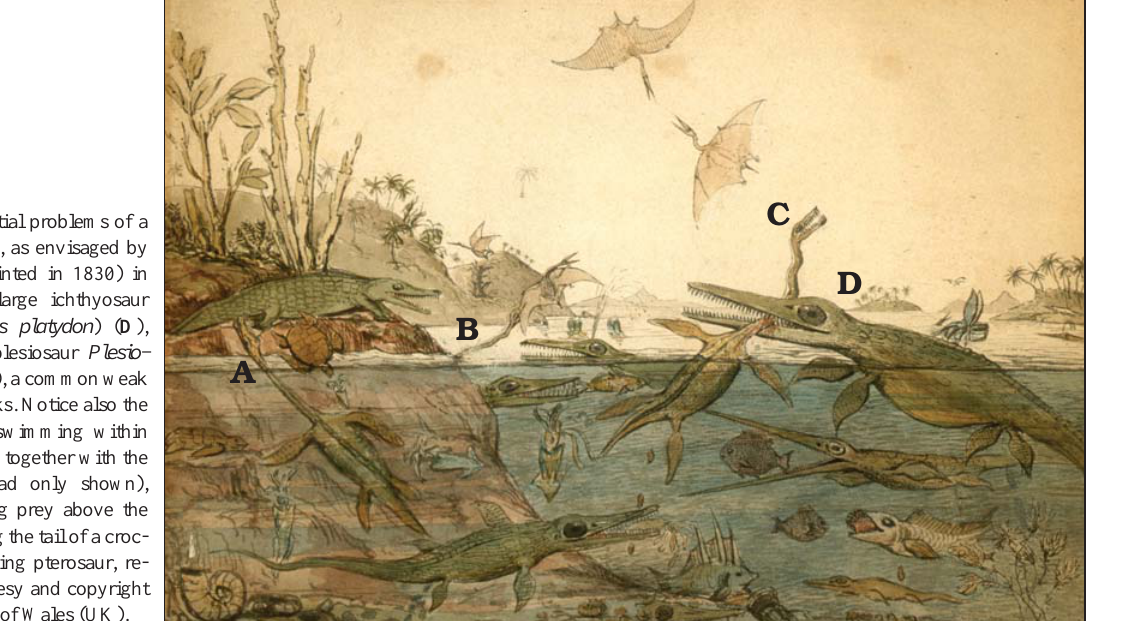
Fig. 2. One of the potential problems of a long neck in plesiosaurs, as envisaged by Henry de la Beche (painted in 1830) in Duria Antiquior . The large ichthyo saur (now Temnodontosaurus platydon ) ( D ), bites the neck of the plesiosaur Plesio- saurus dolichodeirus ( C ), a common weak point for predatory attacks. Notice also the second plesiosaur ( A ) swimming within the water column, which together with the third ( B , neck and head only shown), which are both attacking prey above the air-water interface (biting the tail of a croc- odile and catching a flying pterosaur, re- spectively). Image courtesy and copyright of the National Museum of Wales